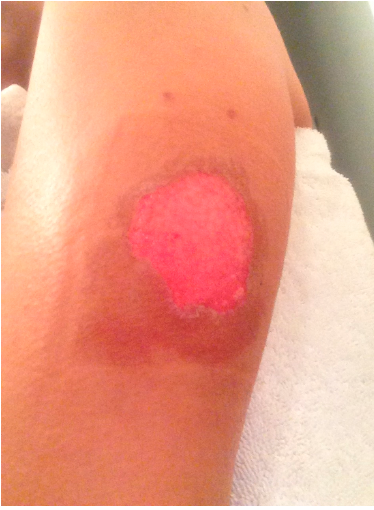
Figure 3. Day 7 post-inoculation with newly denuded skin with circumferential hyperpigmentation.